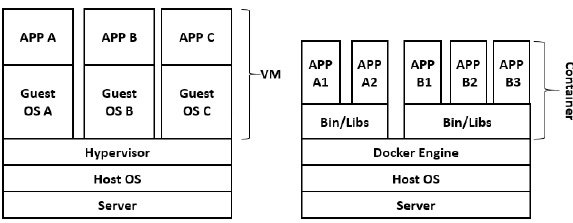
Figure 1. The difference between hypervisor and container architecture Figure 2. Overall system